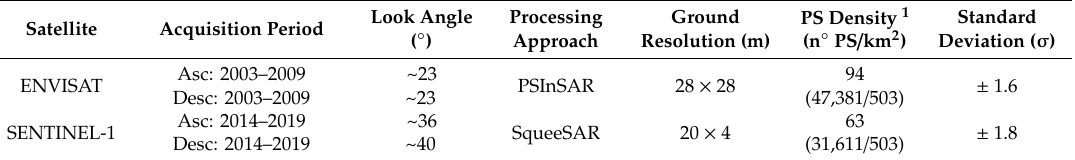
Table 1. Details of the SAR datasets used in this study.